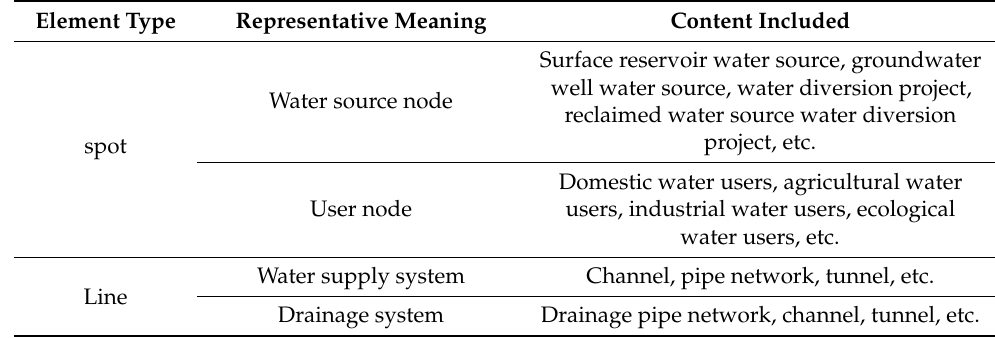
Table 1. Meaning of generalized elements in topological relation diagram.